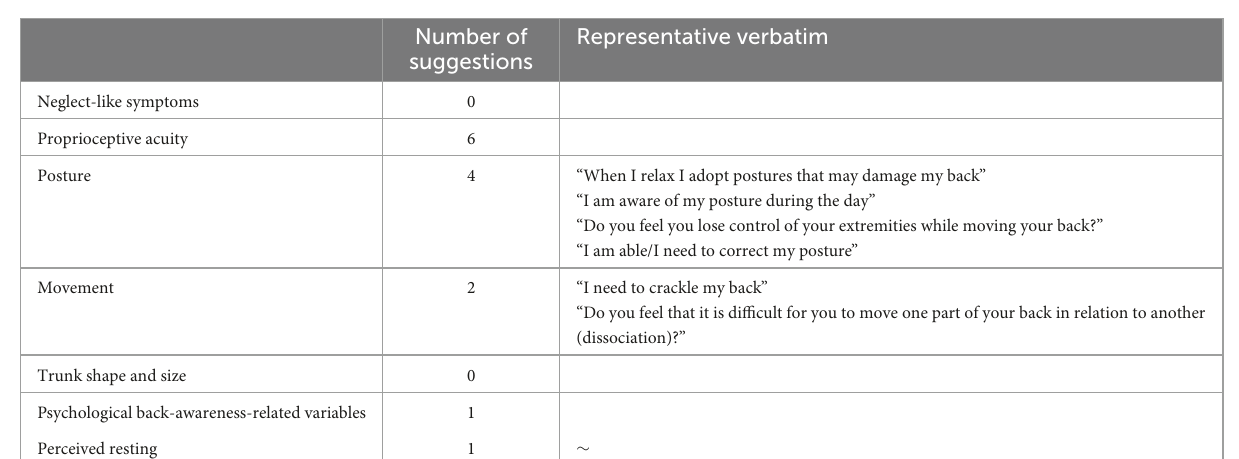
TABLE 4 Variables suggested to be related to back awareness by the control